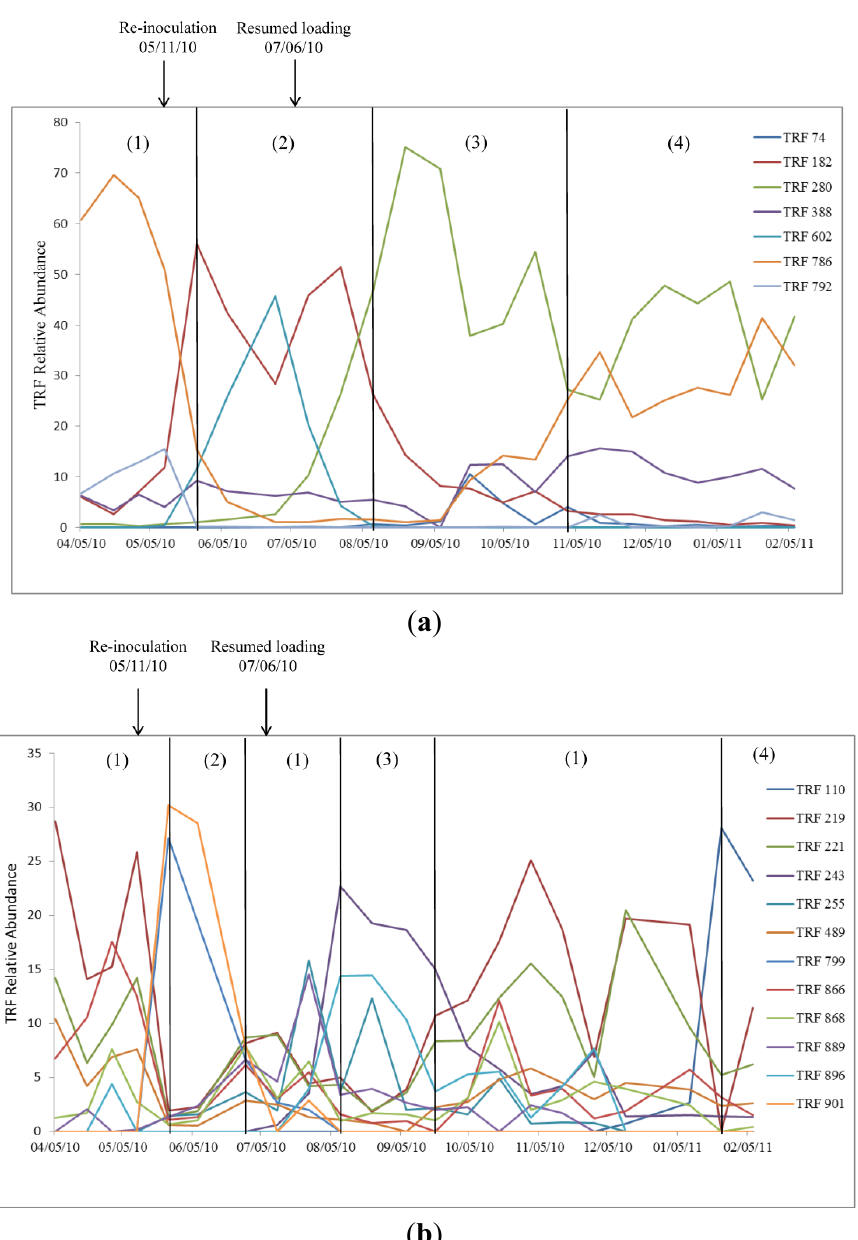
Figure 2. Seasonal variation of the relative abundance of the dominant ( a ) Archaeal and ( b ) Bacterial